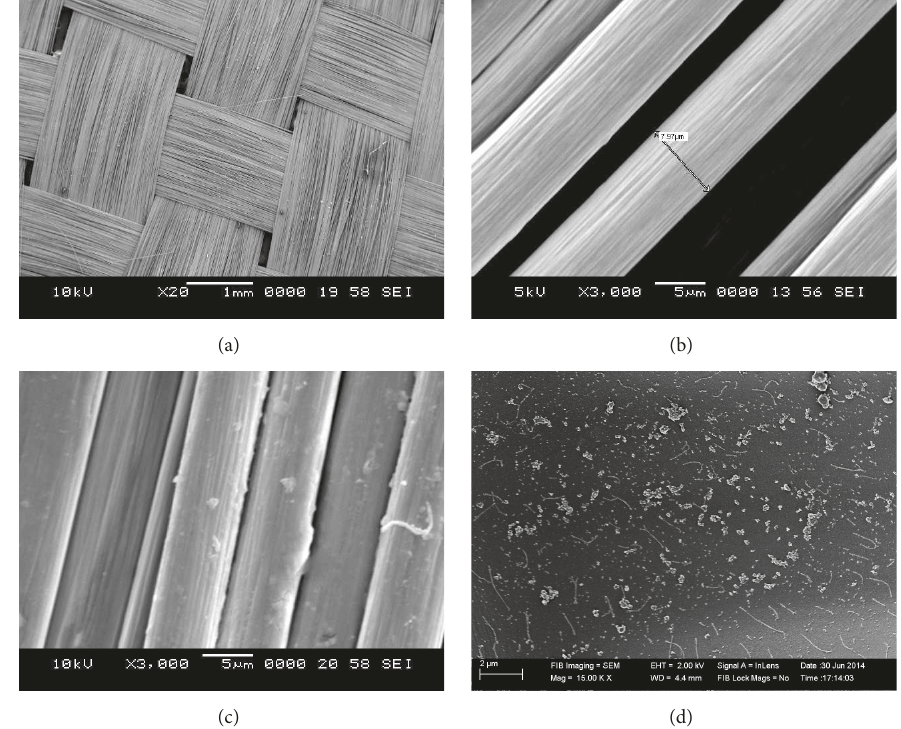
Figure 1: SEM images of (a) carbon fabric, (b) carbon fibers in carbon fabric as-received from the supplier, (c) cryogenically treated carbon fibers, and (d) FESEM image of MWCNTs dispersion in epoxy matrix.